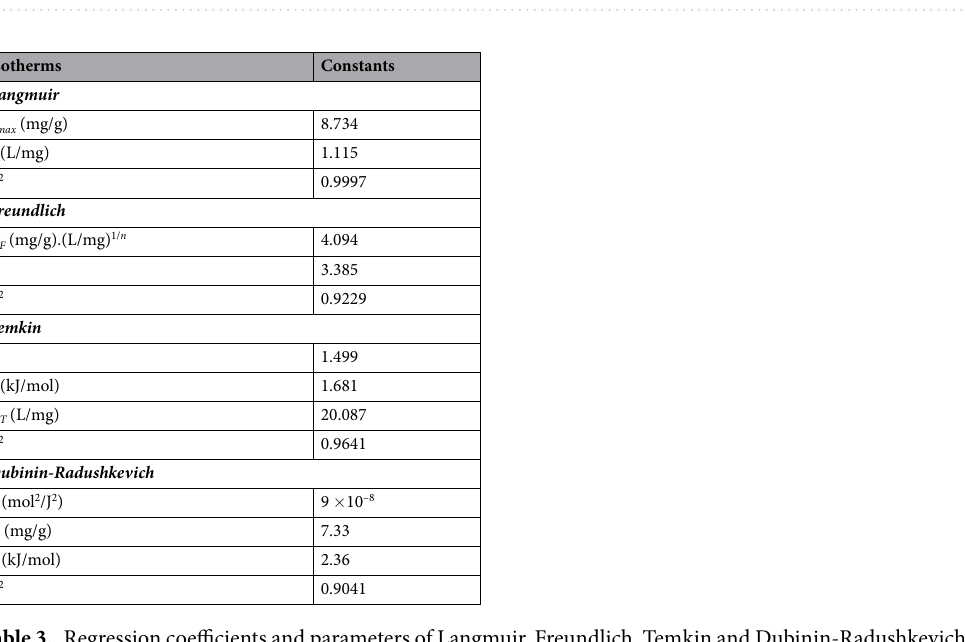
Figure 7. Isotherm plots for adsorption of Pb(II) on H 2 SO 4 -treated CNS at various initial concentrations, C 0 = 10–50 mg/L: ( a ) Langmuir isotherm, ( b ) Freundlich isotherm, ( c ) Temkin isotherm, ( d ) Dubinin-Radushkevich isotherm.